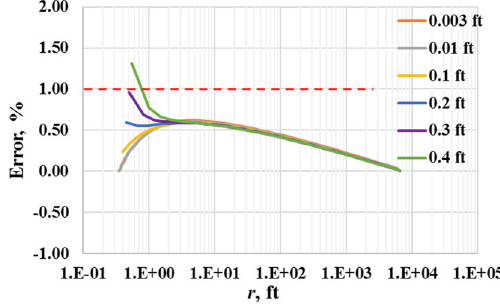
Fig. 3 Error vs. distance from wellbore for different sizes of the innermost cell